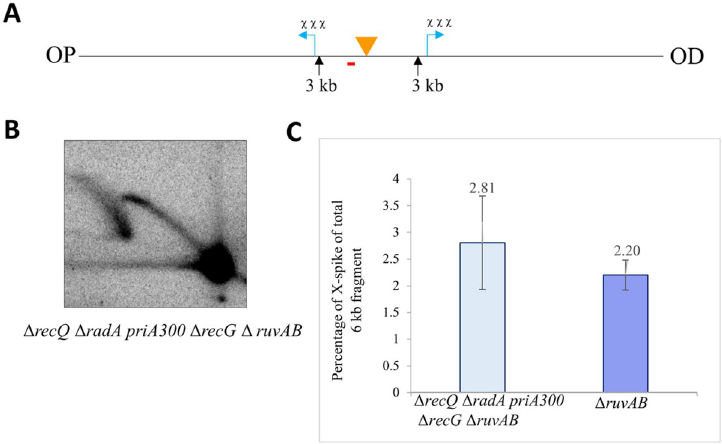
Fig 3. 2-D gel analyses of the central DSB fragment in a Δ recQ Δ radA priA300 Δ recG Δ ruvAB mutant strain and in a single Δ ruvAB mutant strain grown in presence of arabinose. (A) NotI digestion map of the E . coli chromosome between the triple Chi arrays in the mutant strain. The location of the palindrome is shown by an orange triangle and the Chi sites are indicated by blue arrows. NotI recognition sites of interest and their distance from the palindrome are marked by black arrows and numbers (in kb), respectively. The lacZ probe that was used to detect the 6kb fragment is marked by a red line placed below the restriction fragment. OP and OD mean origin-proximal and origin-distal side. (B) Southern blot of a native-native 2-D agarose gel of the crosslinked DNA fragment isolated from a bacterial cell culture grown in presence of arabinose for 60 minutes. The experiment was repeated three times independently. The strain used was DL7667 ( Δ recQ , Δ radA , priA300 , Δ recG and Δ ruvAB , lacZ ::246) (C) Quantification of the HJs generated in crosslinked DNA samples isolated from a Δ recQ Δ radA priA300 Δ recG Δ ruvAB mutant strain and from a single Δ ruvAB mutant strain, represented as the percentage of X-spike out of the total 6kb DNA fragment. Error bars represent the standard error of the mean where n = 3.